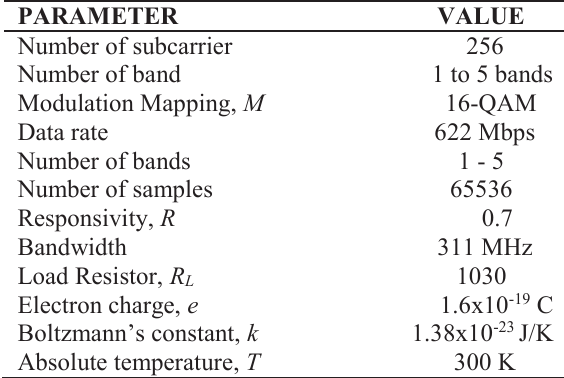
Table 1. Parameters for numerical analysis